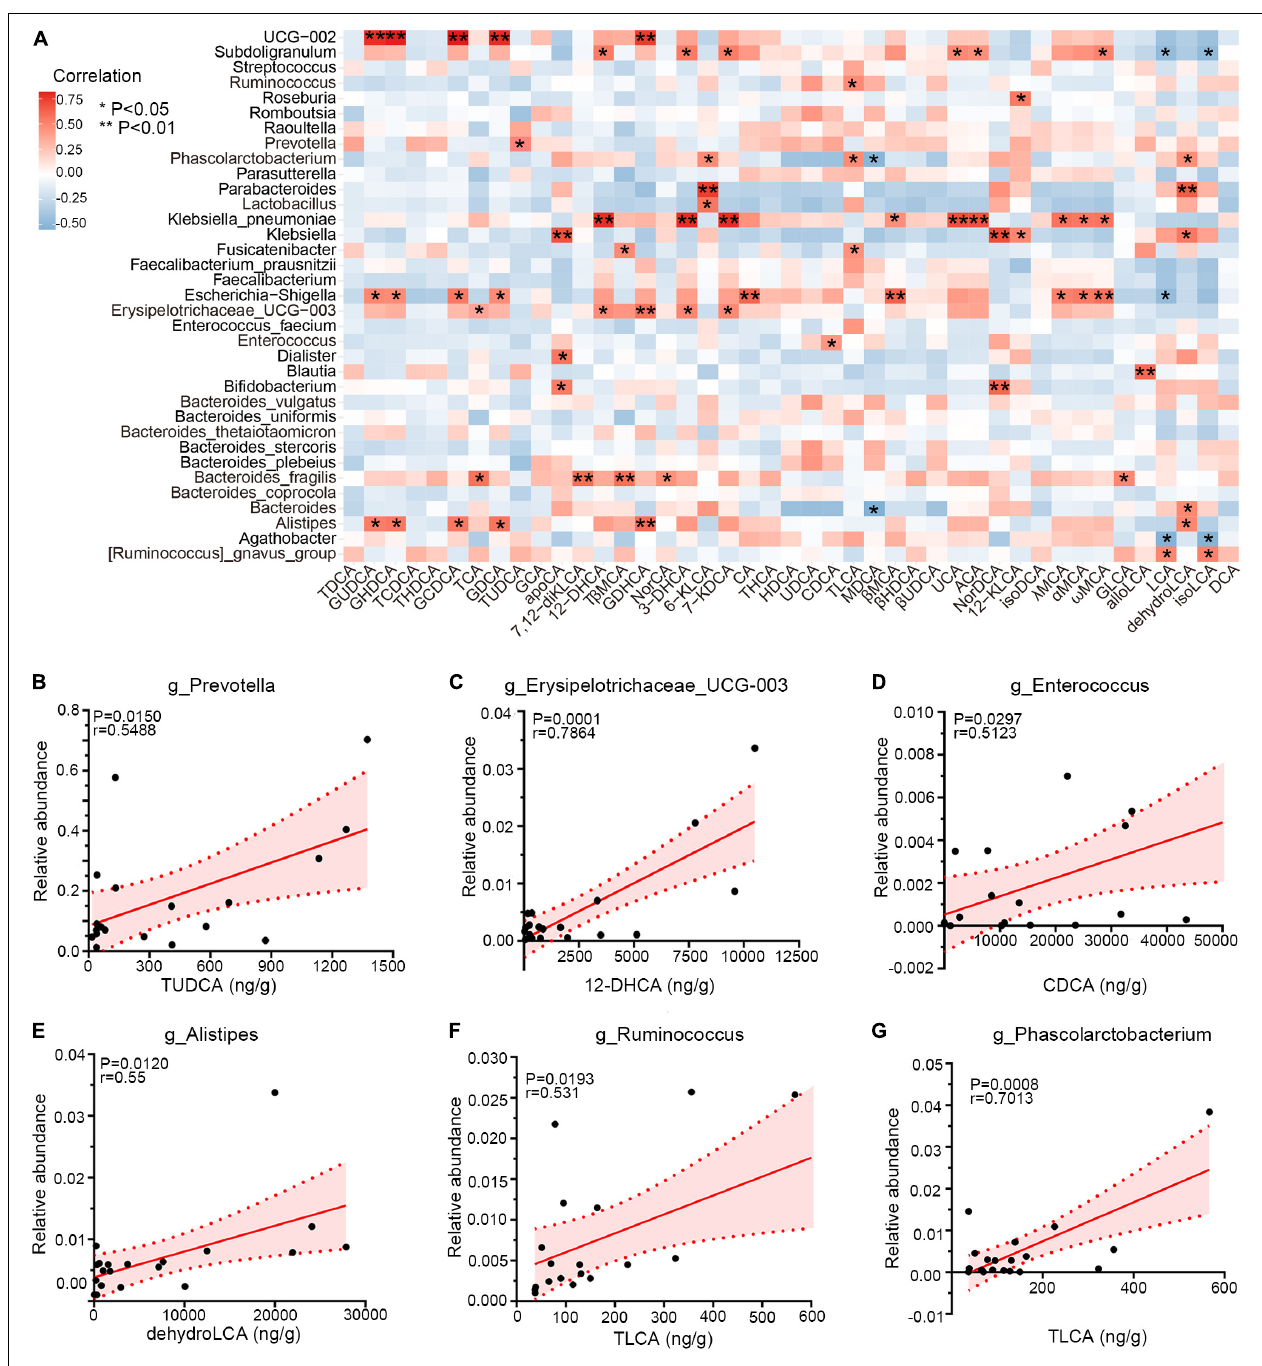
FIGURE 6 | Correlations among gut microbiota and bile acid metabolites. (A) Heatmap of Spearman correlation between relative abundance of gut microbiota and exact concentration of fecal bile metabolites ( n = 20), * p < 0.05, ** p < 0.01. (B–G) Representative linear correlations of diarrhea-linked genera and bile metabolites. Association between Prevotella and TUDCA (B), Erysipelotrichaceae_UCG-003 and 12-DHCA (C) , Enterococcus and CDCA (D) , Alistipes and dehydroLCA (E) , Ruminococcus and TLCA (F) , and Phascolarctobacterium and TLCA (G) . Pink dotted lines show error bar and pink area for 95% confidence interval; red denotes positive association. Single datum point was abandoned once it deviated the correlation line dramatically.